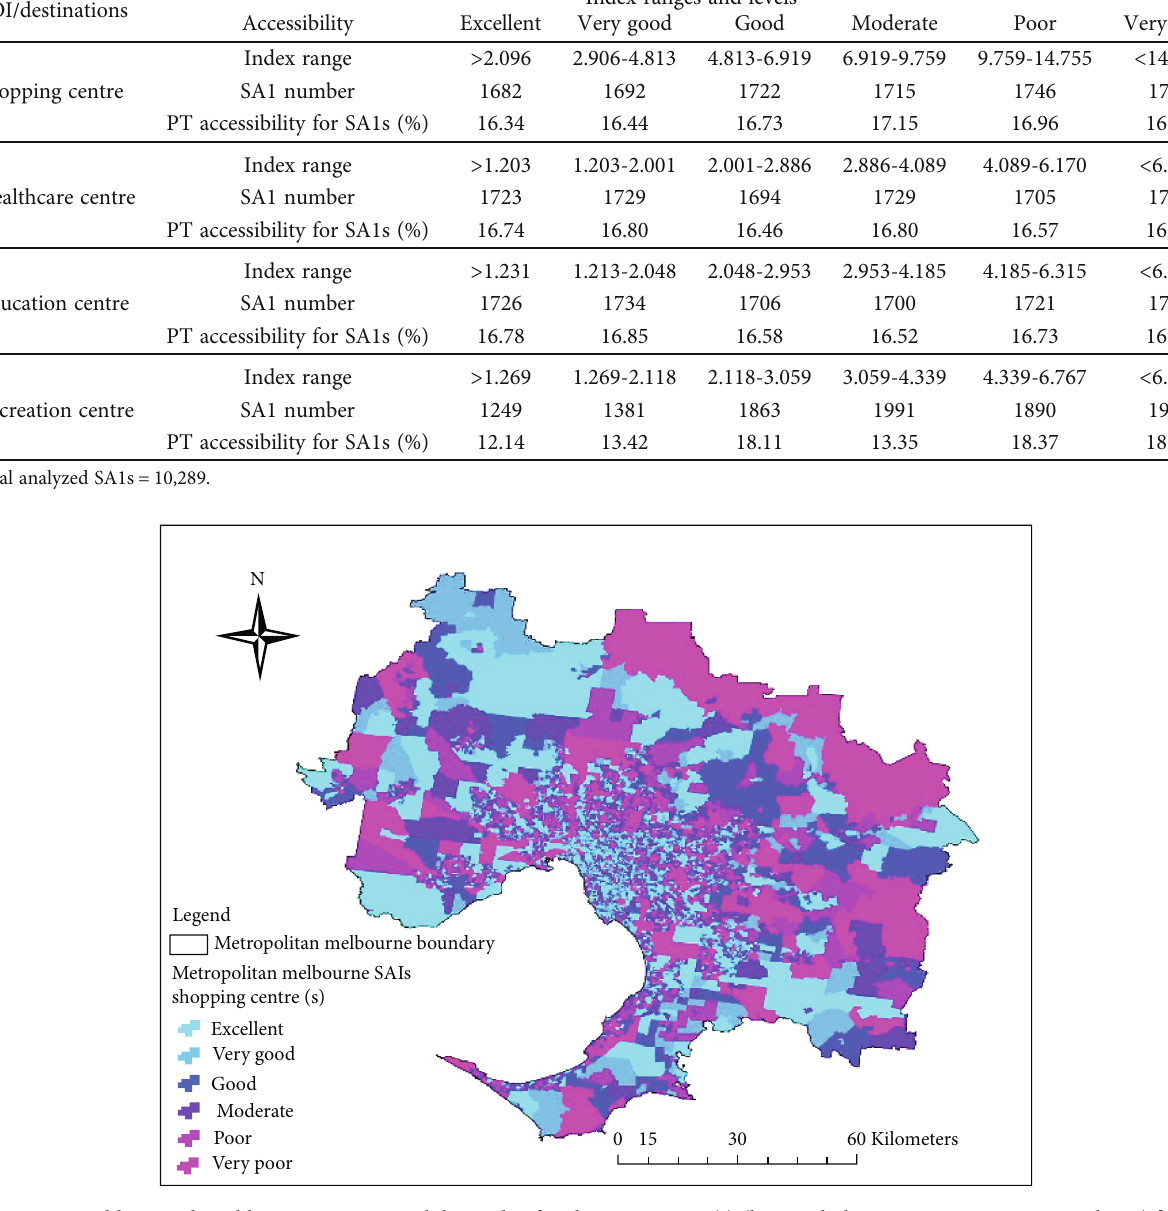
Figure 2: Older people public transport accessibility index for shopping centre(s) (https://desktop.arcgis.com/en/arcmap/latest)